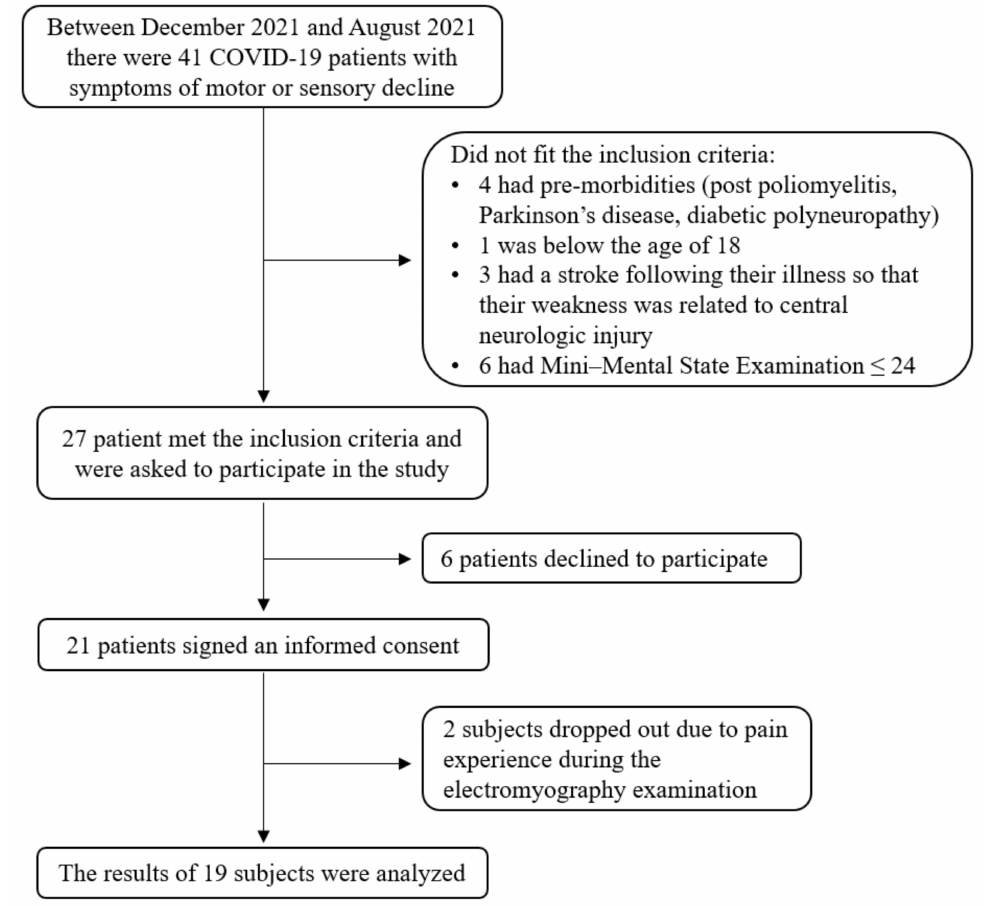
Figure 1. The recruitment of coronavirus disease 2019 (COVID-19) patients for this study. Tools and protocol: Subject demographics and rehabilitation measures were acquired from the hospital records. Data included were age, sex, comorbidity of diabetes, duration in acute hospitalization, duration of ventilation, steroids (yes/no), and duration of reha- bilitation. Additionally, the World Health Organization (WHO) clinical progression scale for COVID-19 patients [20] was used. The scale ranges from ‘0 (cid:48) (uninfected) to ‘10 (cid:48) (dead) and the values of 1–9 are divided to group of ambulatory mild disease (1–3 that differ by factors of asymptomatic or not, independent or not), hospitalized moderate disease (4–5 that differ by with or without oxygen by mask or nasal prongs), and hospitalized severe disease (6–9 that differs by invasive or non-invasive mechanical ventilation, levels of pO 2 /FiO 2 and SpO 2 /FiO 2, need of vasopressors, dialysis or ECMO) [20]. Each subject marked the perceived level of pain, which is one of the clinical features of COVID-19 [21]) on a Visual Analogue Scale (VAS) rated from ‘0 (cid:48) (no pain) to ‘10 (cid:48) (worst imaginable pain). Clinical evaluation distinguished between nociceptive (musculoskeletal) and neuropathic pain types [22]. The following measures were taken at admission and at discharge: the FIM, which is comprised of 18 items, grouped into motor and cognition sub- scales. Each item is scored on a scale of ‘1 (cid:48) (total assistance or not testable) to ‘7 (cid:48) (performs independently in a safe and timely manner). Higher score reflects high independence in activities of daily living. The Minimal Clinically Important Difference (MCID) of the FIM was determined for post stroke patients as 3 for cognitive FIM, 17 for motor FIM, and 22